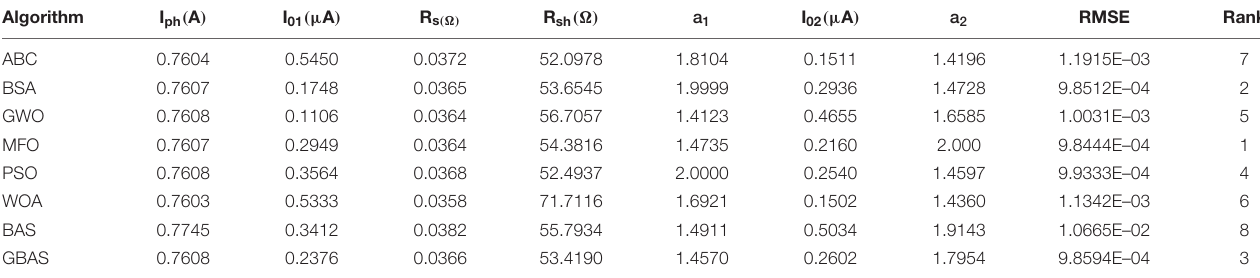
TABLE 9 | Model parameters identified by various algorithms for double diode model